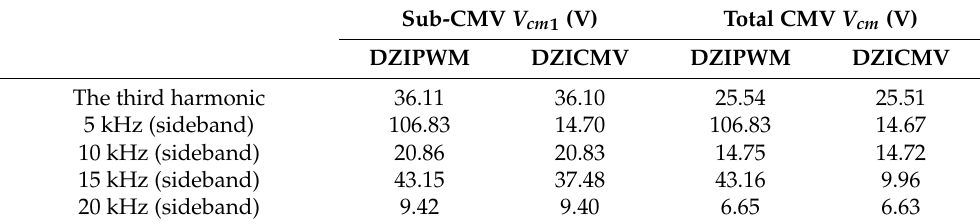
Table 8. The CMV maximum harmonic amplitudes for DZIPWM and DZICMV.